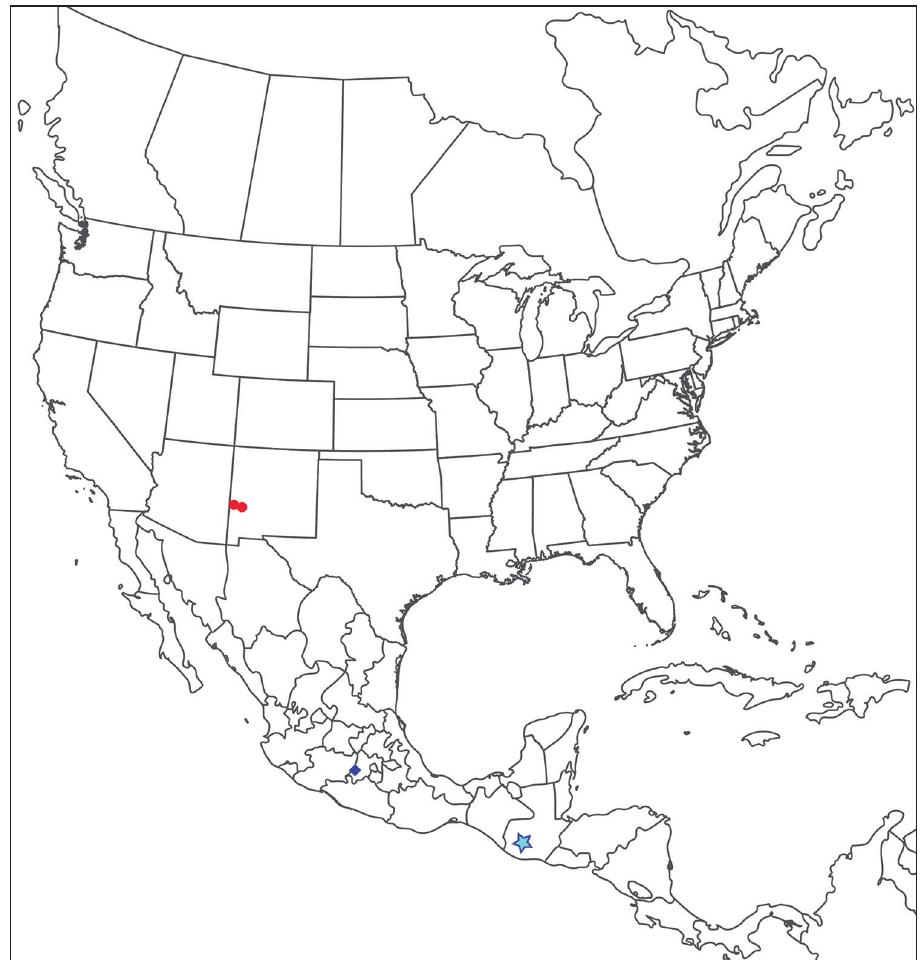
Figure 29. Torrenticola boettgeri distribution. Blue star represents type locality (Viets 1977a); blue dia- mond represents additional published record (Cramer 1992, as T. esbelta comb. n.); and red circles repre- sent new records and material